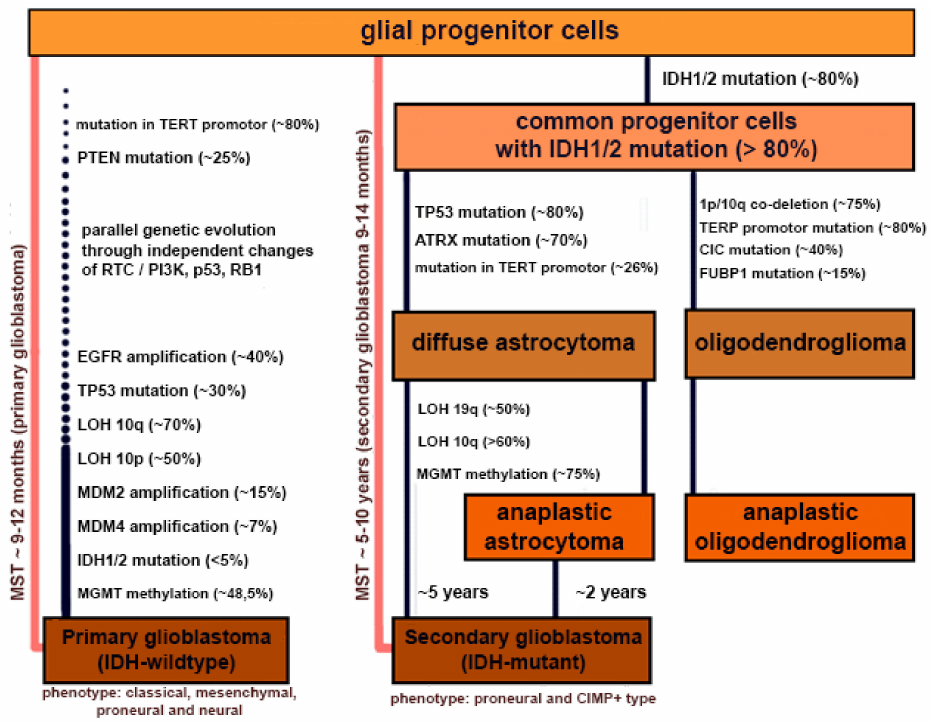
Figure 1. Molecular alterations responsible for glioblastoma carcinogenesis [66–85]. Table 1. Characteristics of primary and secondary glioblastoma